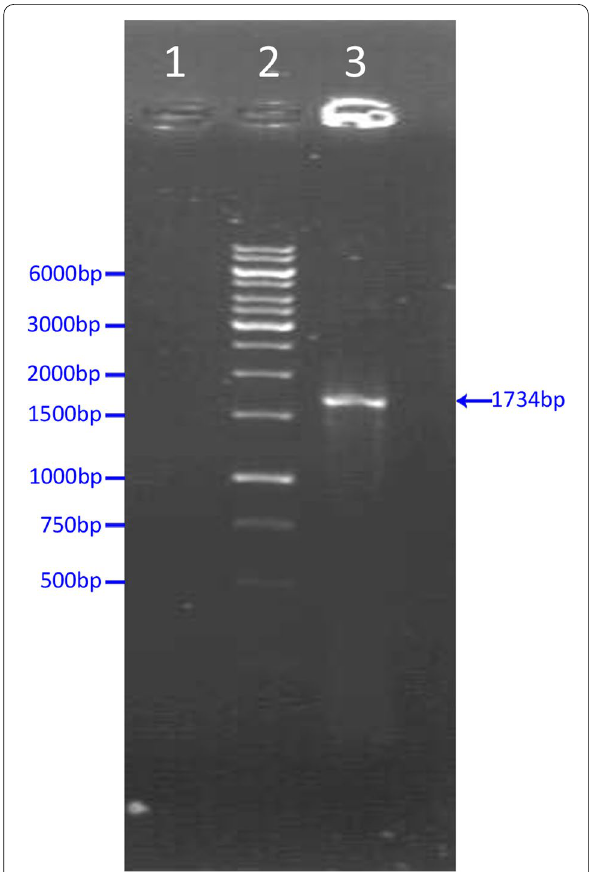
Fig. 1 Gel electrophoresis analysis of HN gene (1734 bp) RT-PCR products. Lane 1: negative control. Lane 2: 1-kb DNA size marker (Fermentas #SM0311). Lane 3: demonstrating a thick bond of 1734 bp